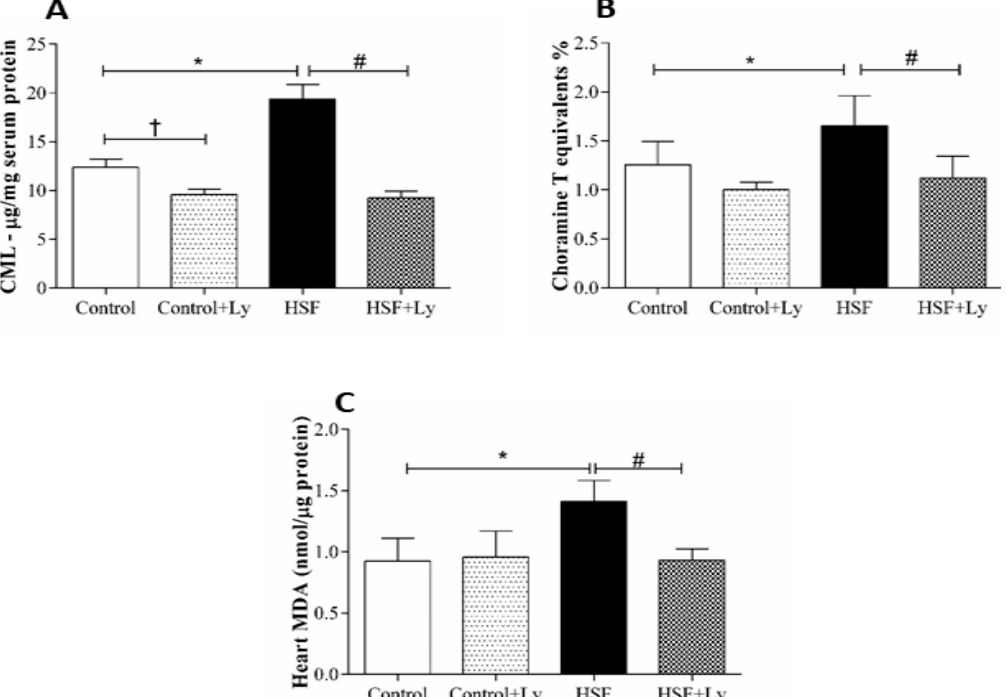
Figure 3. Plasma and cardiac tissue redox state parameters. A —Carboxymethyl lysine (CML-pg/mg protein); B —Cholaramine T equivalents %; C —Malondyhaldeide (MDA-nmol/µg protein). Data are expressed in mean ± standard deviation ( n = 6 animals/group). Comparison by Two-way ANOVA with Tukey post-hoc ( p < 0.05), *HSF vs Control; # HSF vs HSF + Ly.